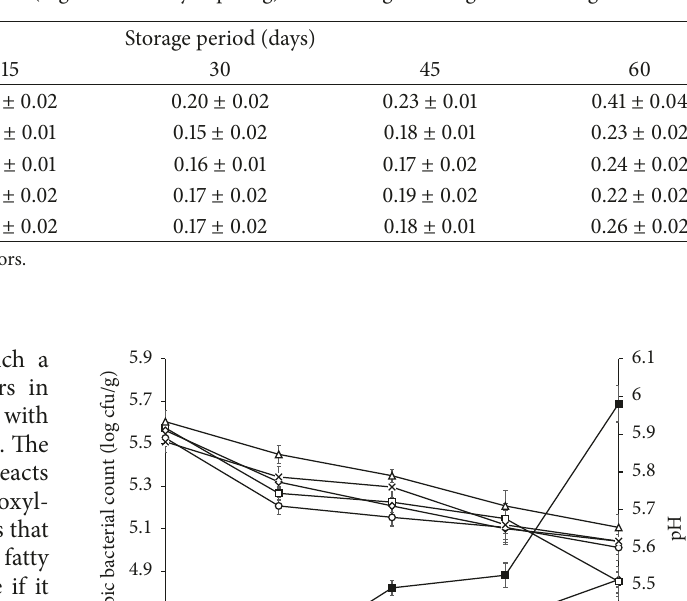
Table 2: Thiobarbituric acid reactive substances (TBARS) values (mg malonaldehyde per kg) of beef burger during frozen storage at − 18 ∘ C.